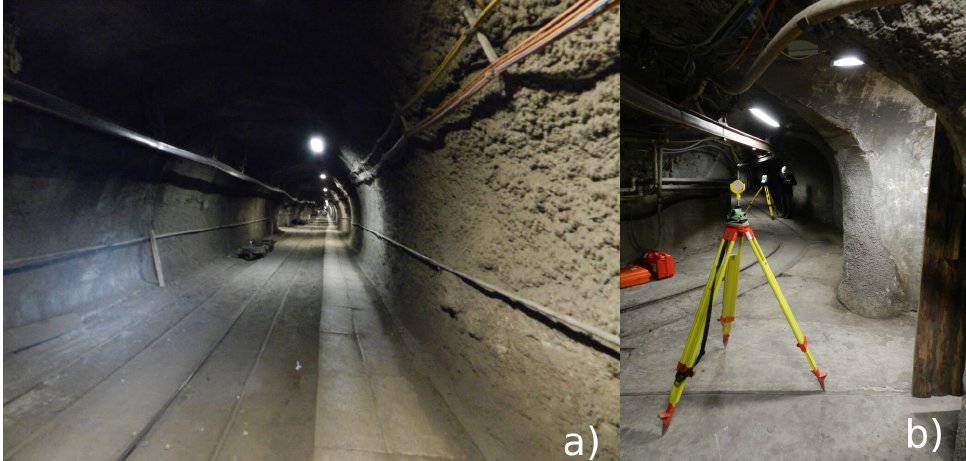
Figure 1. Traversing through underground tunnels in Velenje Coal Mine. ( a ) Straight segment, ( b ) retro-reflector and total